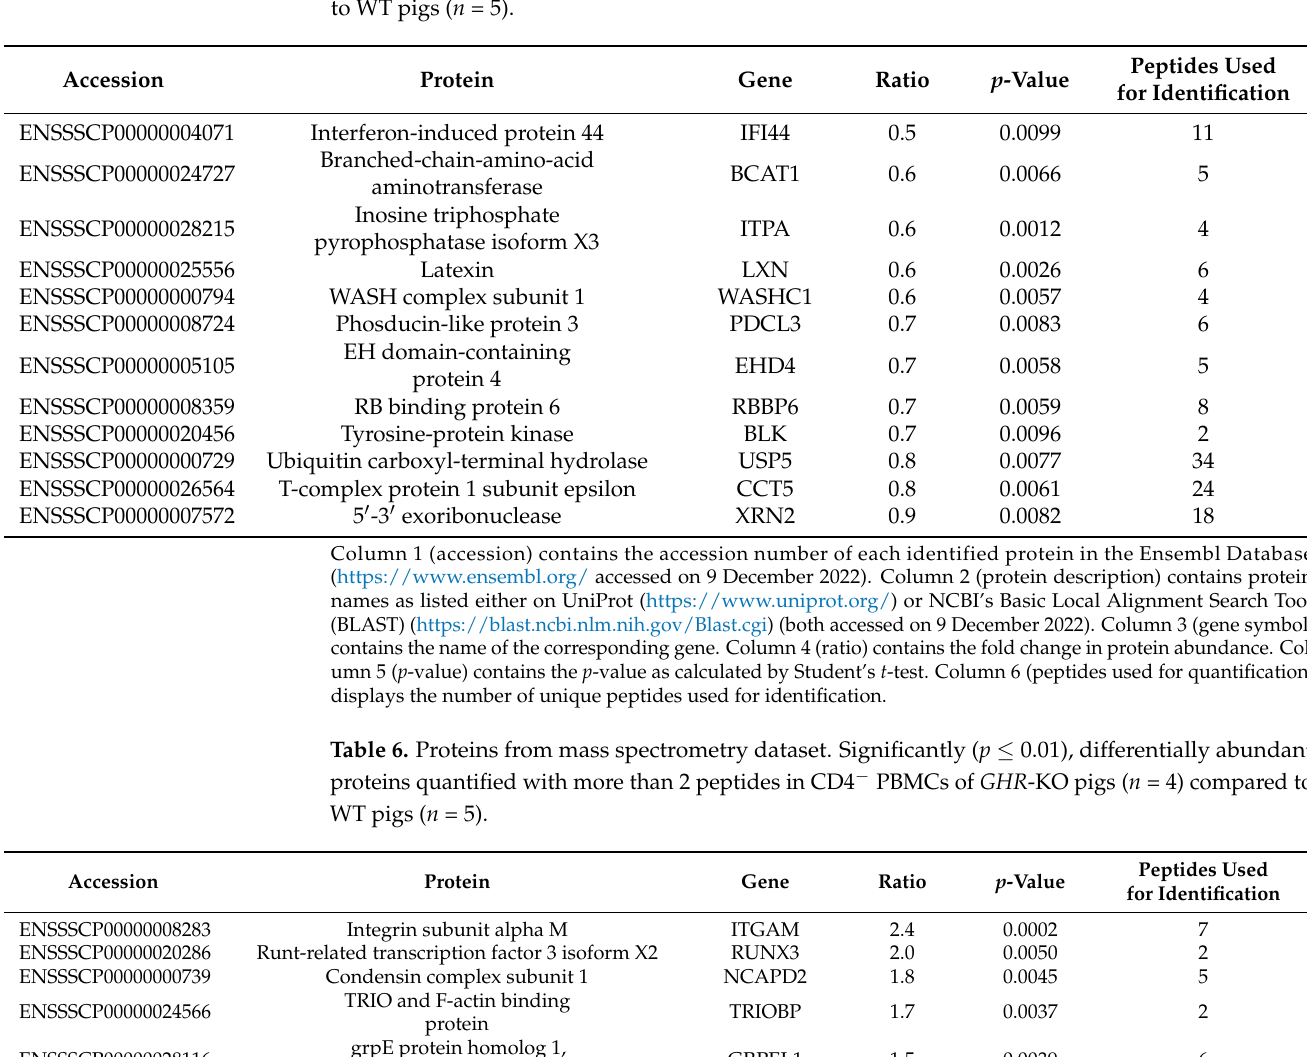
Table 5. Proteins from mass spectrometry dataset. Significantly ( p ≤ 0.01) differentially abundant proteins, quantified with more than 2 peptides in CD4 − PBMCs from GHR -KO pigs ( n = 4) compared to WT pigs ( n = 5).